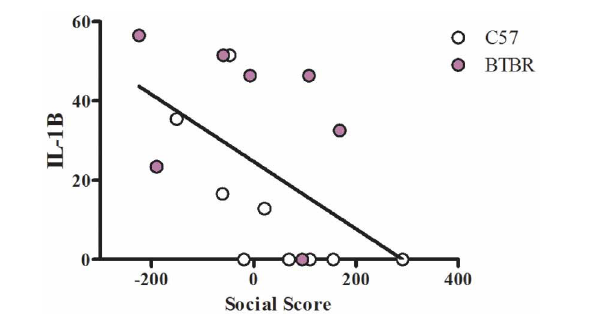
FIGURE 2 | Social correlation in IFN γ /LPS stimulated macrophages. Scatter graphs and linear regression of IL-1 β in IFN γ stimulated macrophages. Correlation coefficients ( r- values) and p- values were calculated with Spearman’s correlation analysis. C57 r- value: − 0 . 80, p-